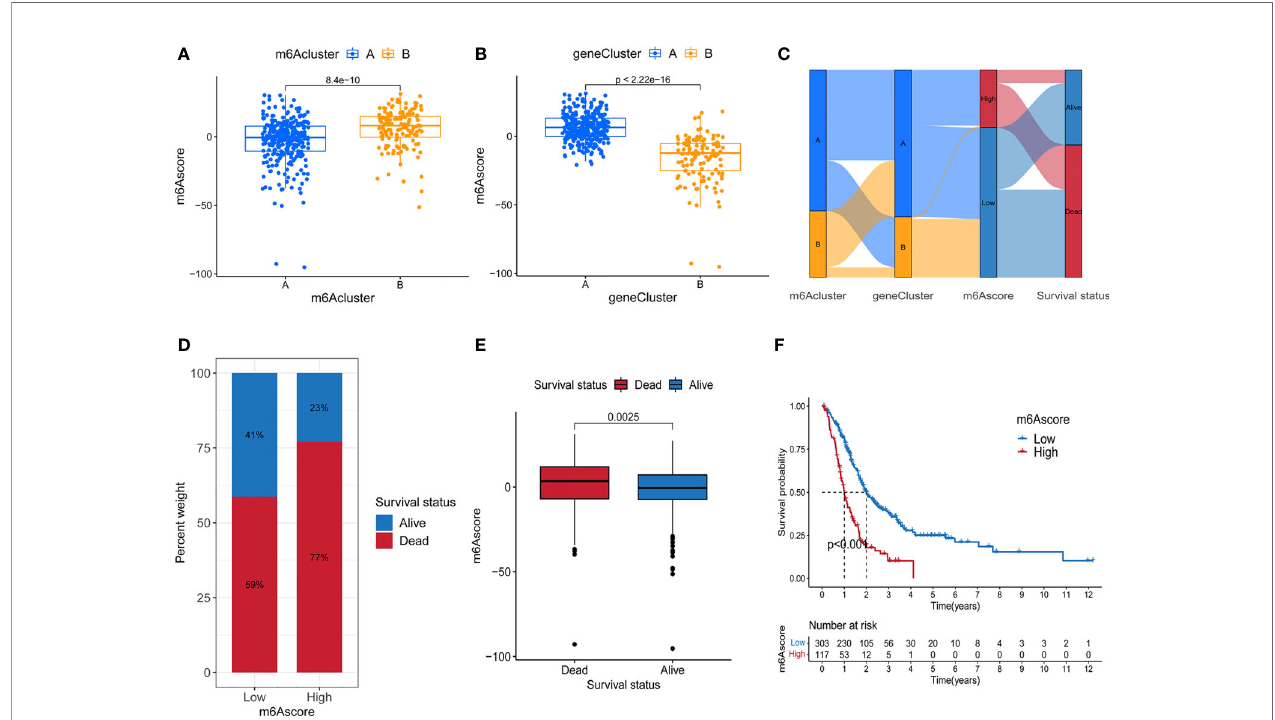
FIGURE 4 | Construction of m 6 A score. (A) Difference of m 6 A score between two m 6 A methylation modi fi cation subtypes. (B) Difference of m 6 A score between two m 6 A-related gene subtypes. (C) Alluvial diagram containing m 6 A cluster, gene cluster, m 6 A score and survival changes. (D) The proportion of survival and death in high and low m 6 A score group. (E) Comparison of m 6 A scores between surviving and dead patients. (F) Survival analysis of high and low m 6 A score